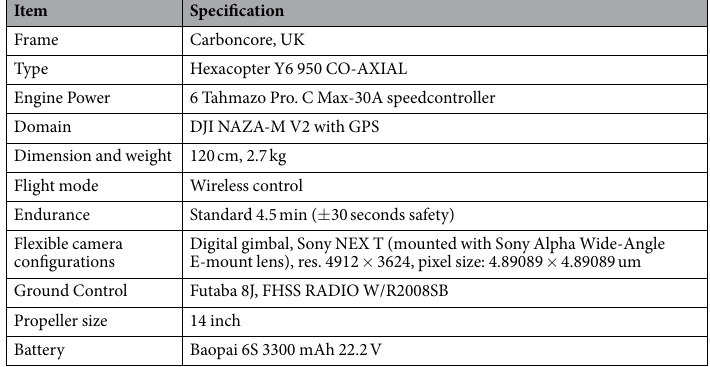
Table 1. Key specifications of the self-assembled Unmanned Aerial Vehicle (UAV) system.